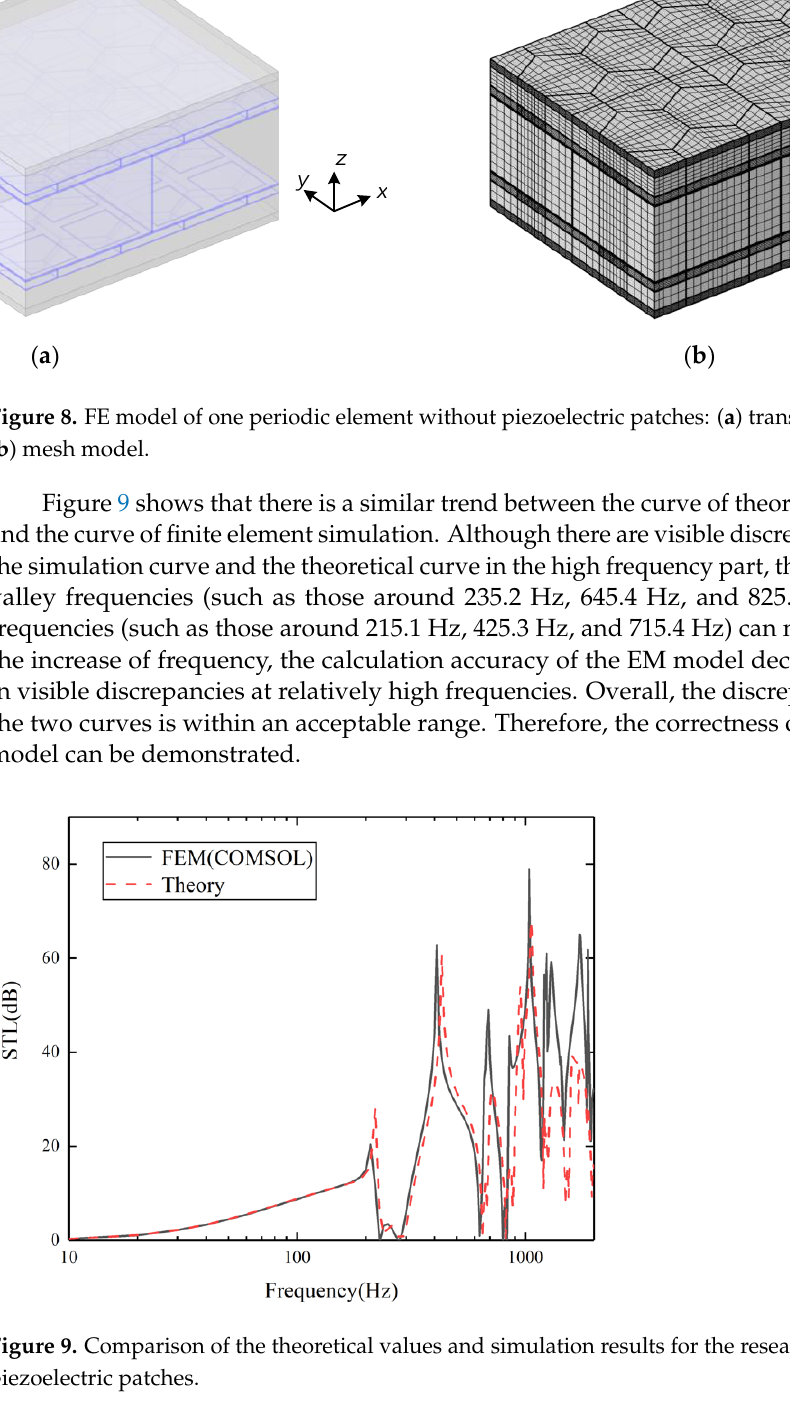
Figure 9. Comparison of the theoretical values and simulation results for the research model with- piezoelectric out piezoelectric patches.